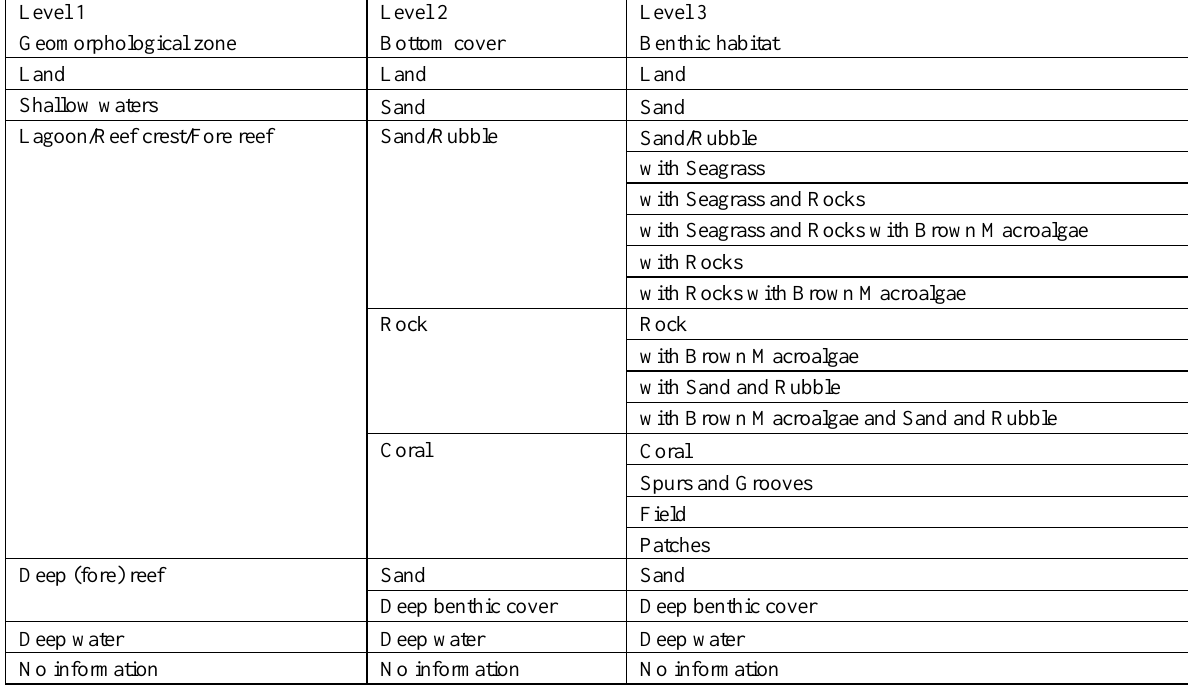
Table 1. Geomorphological, bottom cover and benthic habitat classification scheme applied in the mapping of the